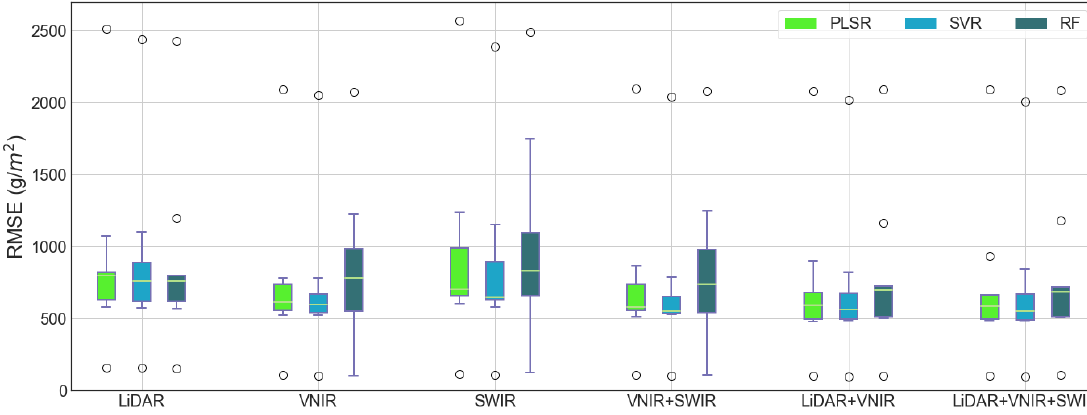
Figure A6. Box plot of the prediction results for various data sources and regression methods.